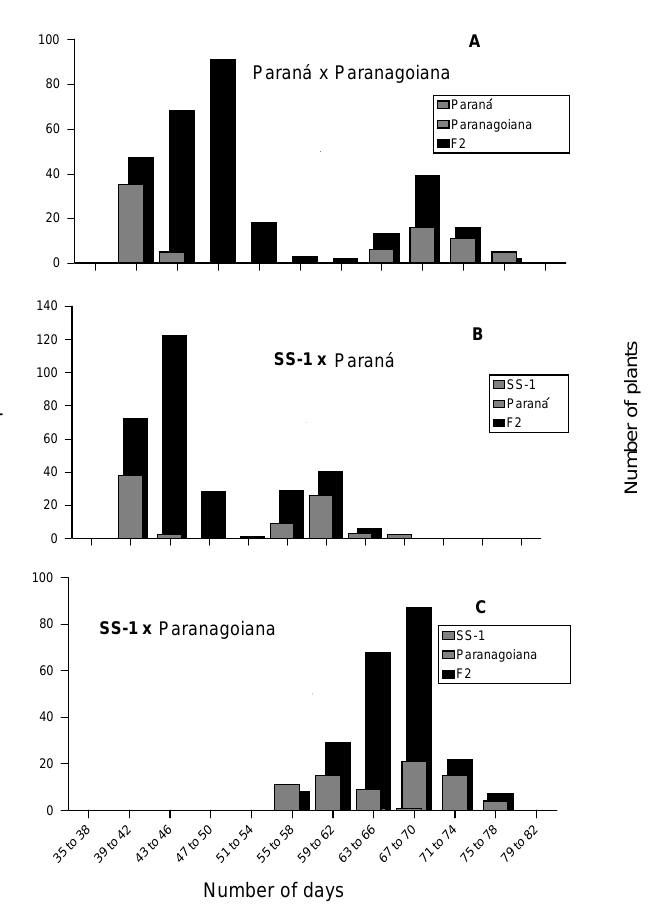
generations for the num- 2